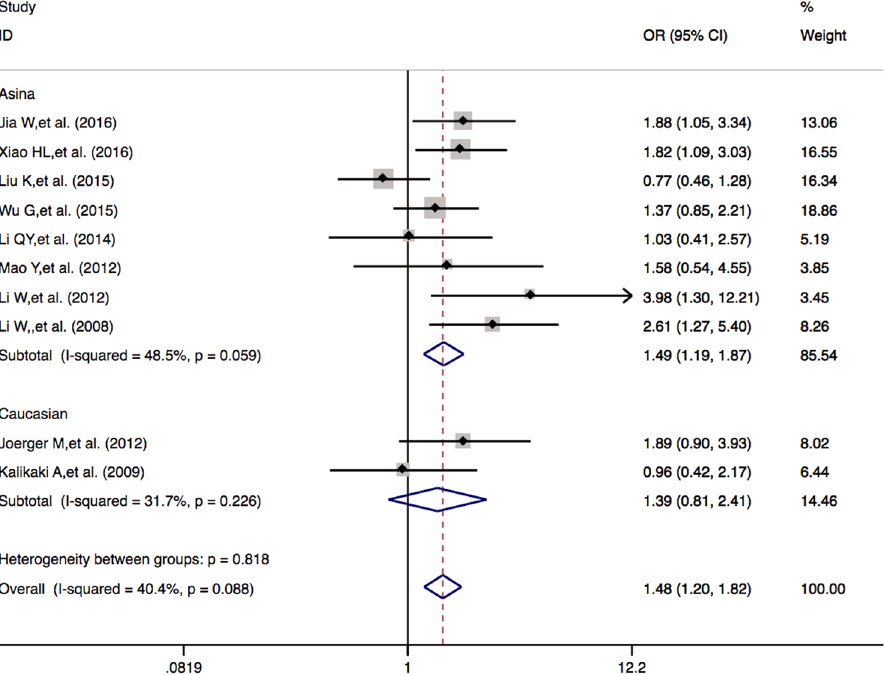
Figure 3. Forest plots of ORR in NSCLC patients treated with platinum-based chemotherapy by the GSTM1 null or present polymorphism (null vs . present). Odds ratios (ORs) (and its 95% confidence interval (CI)) of objective response rate (ORR) stratified by ethnicity for the GSTM1 null or present polymorphism IIe/Val + Val/ Val vs .